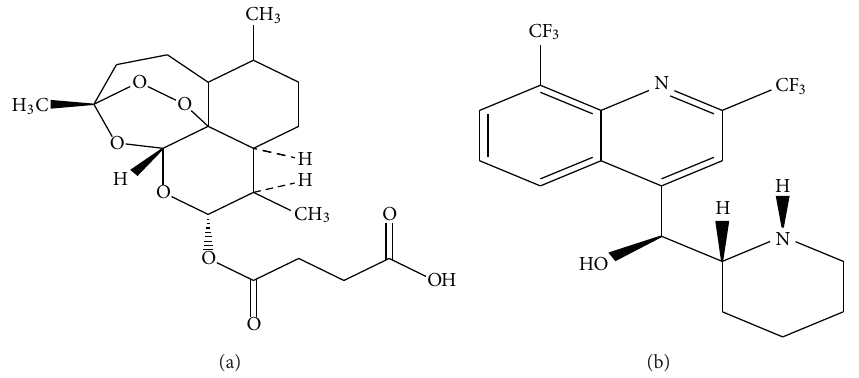
F 1: (a) Structure of Artesunate and (b) structure of Me�oquine.